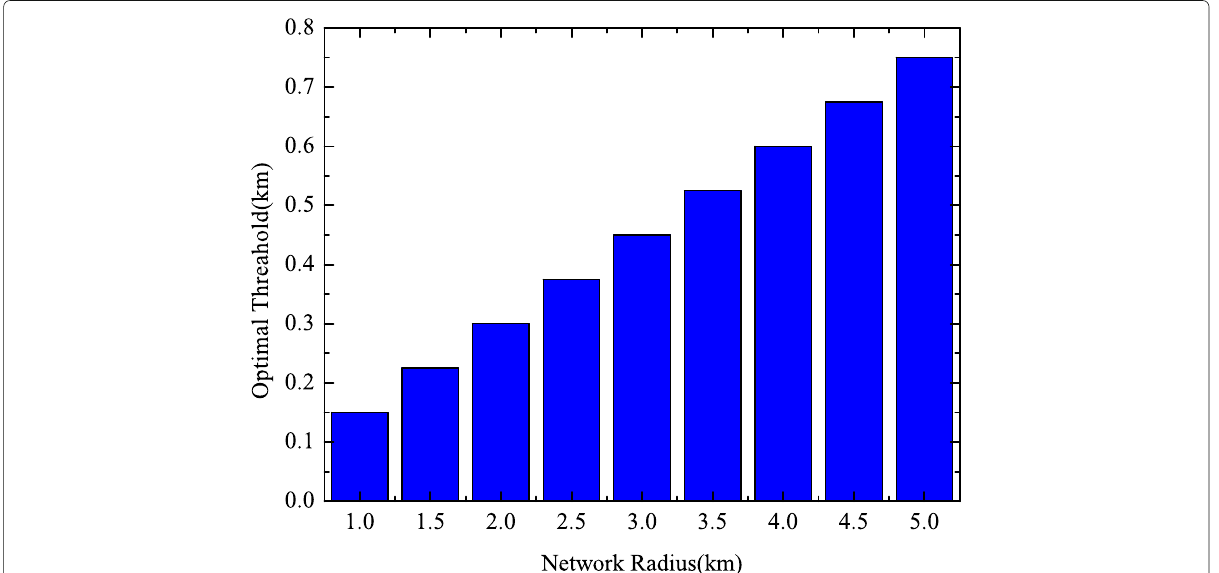
Fig. 3 Optimal threshold at different network radiuses. The abscissa is the network radius (km) and the ordinate is the optimal threshold (km)